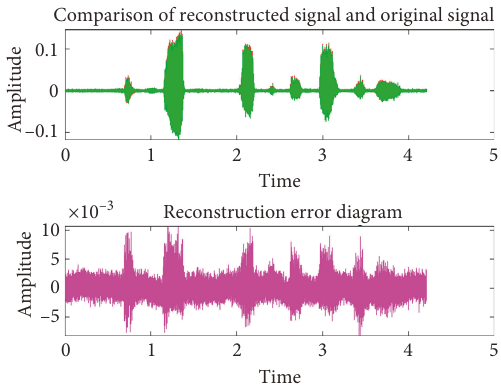
Figure 11: Comparison of reconstructed signal and original